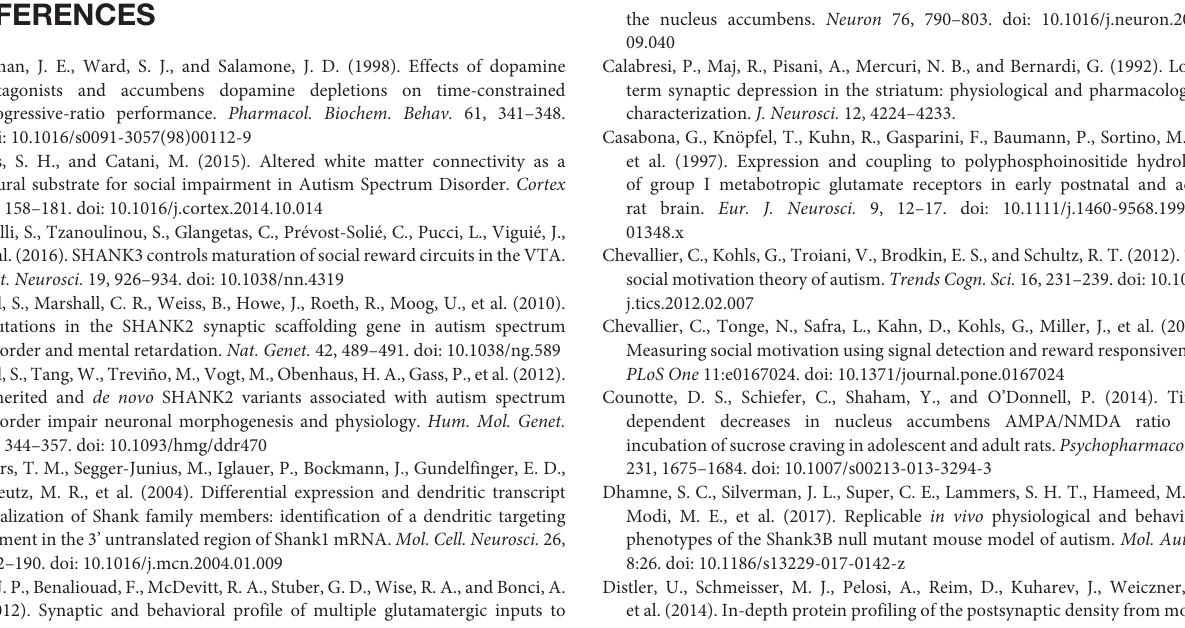
FIGURE S1 | Generation and validation of the Shank2 KO rat model. Genomic PCR strategy (A) determined gDNA sequence deleted in two rat Shank2 KO lines (8A and 13) including PCR strategy design and primers to detect deletions. DNA gel is example of WT, Het and KO animals’ genomic PCR results showing expected gPCR products of 1171 bp (WT) and 501 bp (KO). (B) Entire Shank2 western blot of whole brain and synaptosome preparations for WT, Het and KO animals from Figure 1C .